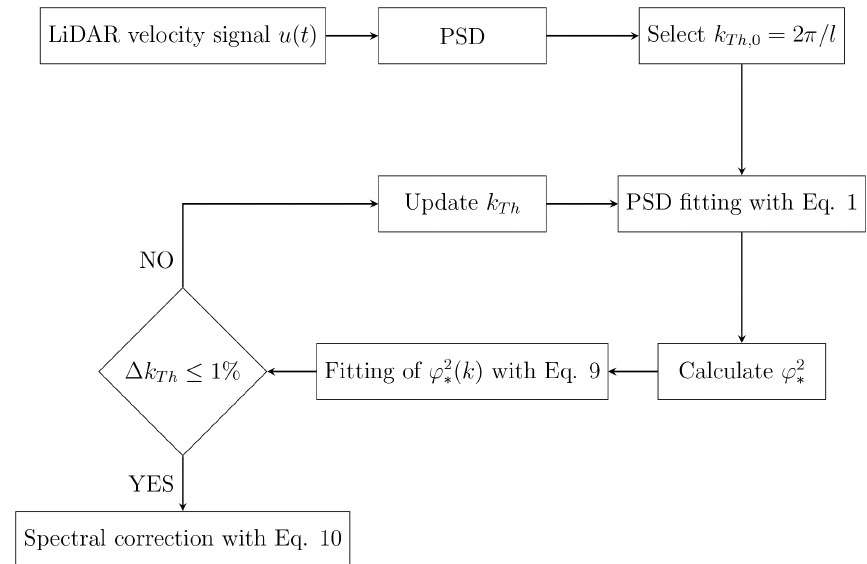
Figure 1. Flowchart for the iterative correction procedure of the lidar velocity measurements.